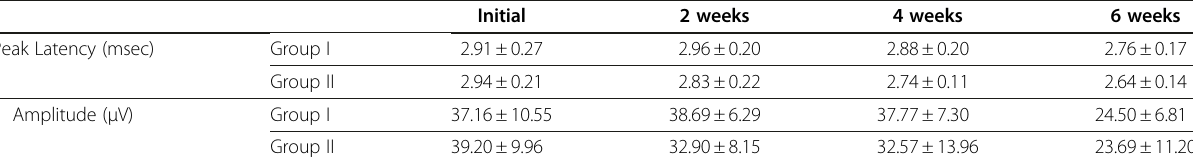
Table 1 Sensory nerve conduction study in tail of rats